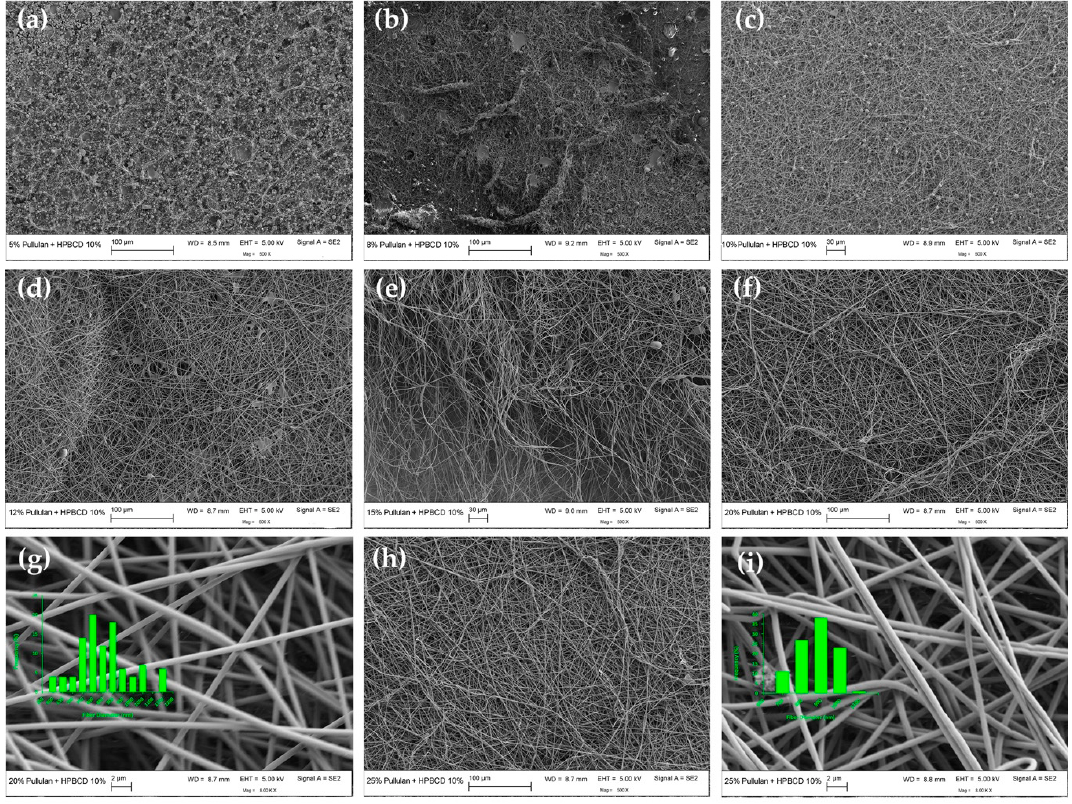
Figure 5. SEM images and diameter histograms of electrospun fibers containing 10% (w/v) HP- β -CD and di ff erent pullulan contents: ( a ) 5, ( b ) 8, ( c ) 10, ( d ) 12, ( e ) 15, ( f , g ) 20 and ( h , i ) 25% (w / v). Fiber size distributions are only presented for smooth and bead-free spunfibers.